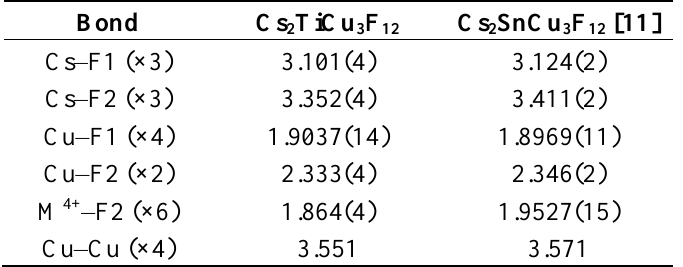
Table 2. Metal—fluorine bonds and Cu–Cu distances (Å) for Cs 2 TiCu 3 F 12 and Cs 2 SnCu 3 F 12 ( R 3̅ m model at room